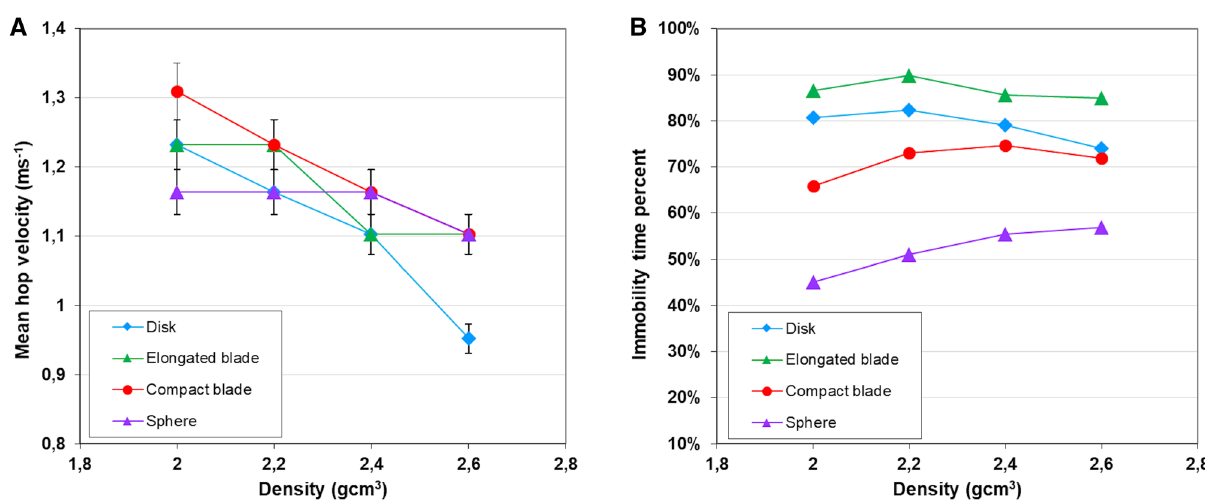
Figure 4. ( A ) Mean hop velocity and ( B ) time fraction of immobility of the 16 different artificial